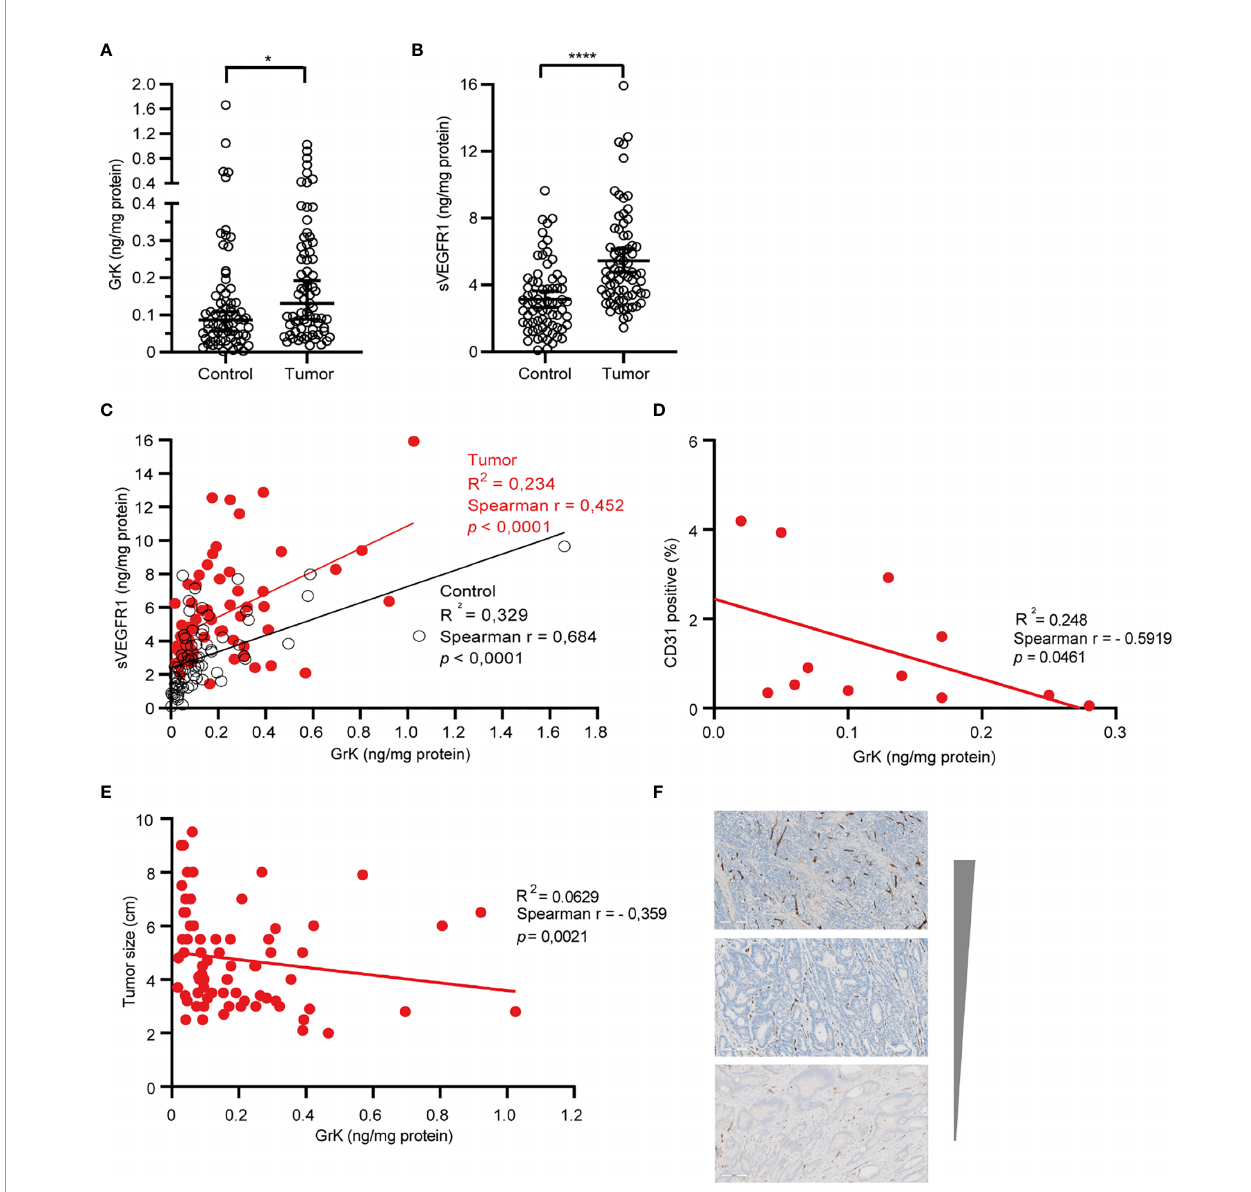
FIGURE 6 | GrK and sVEGFR1 protein levels correlate in colorectal cancer tissue (A) Comparison of the concentration of sVEGFR1 in colorectal cancer and normal control (Wilcoxon signed rank test). Data were corrected for total protein levels. (B) Comparison of the concentration of GrK in colorectal cancer and normal control (Wilcoxon signed rank test). Data were corrected for total protein levels. (C) Correlation between sVEGFR1 and GrK concentrations in colorectal cancer and in normal control (Spearman ’ s rank correlation). (D) correlation between endothelial cells by CD31 and GrK in T4 colorectal cancer (Spearman ’ s rank correlation). (E) Correlation between GrK and Tumor size in colorectal cancer (Spearman ’ s rank correlation). (F) CD31 IHC staining of colorectal tumors. Three representative images are shown with high, intermediate and low amounts of angiogenesis Results are depicted as median and 95% CI. *P < 0.05; ****P <